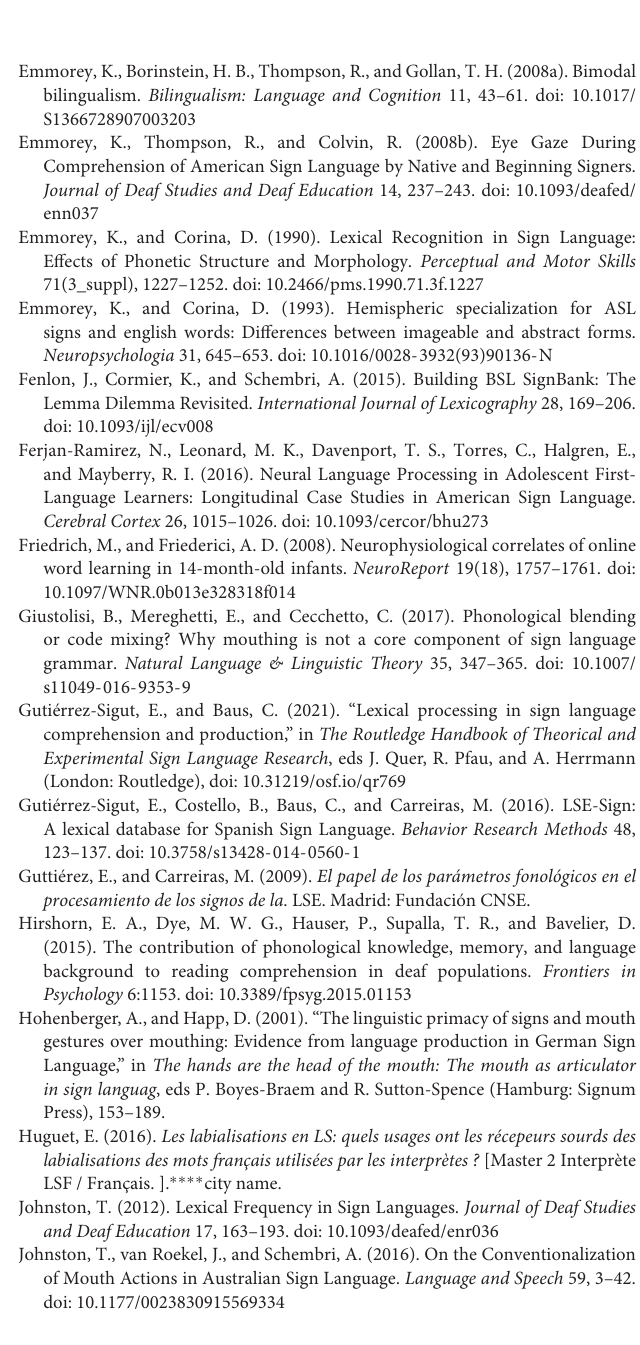
Supplementary Table1 | List of stimulus items. The table lists all 400 items presented in the lexical decision experiment. Supplementary Video 1 | Pomme (Apple) manual sign presented in the five